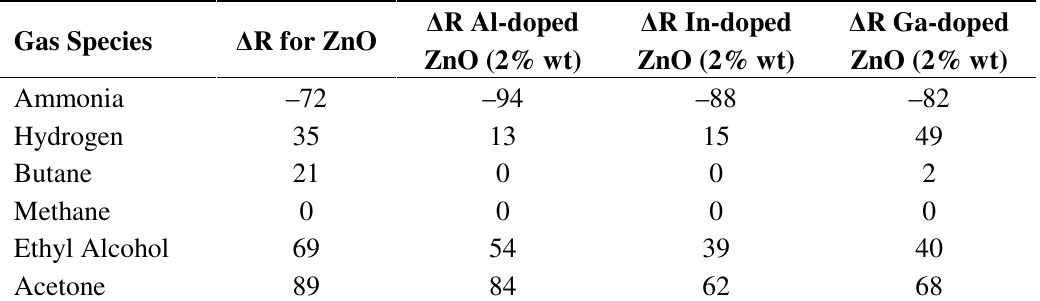
Table 4. Showing the resistance change of different forms of ZnO (doped and un-doped) in the presence of different gases. Taken from H. Nanto